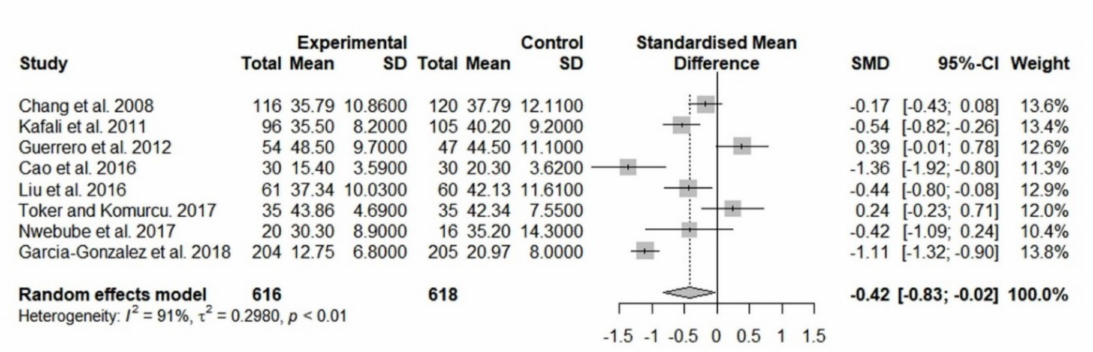
Figure 2. Forest plot of pooled anxiety scores after the intervention, comparing the music group and the control group (overall meta-analysis). SD, standard deviation; SMD, standardized mean di ff erence; CI, confidence